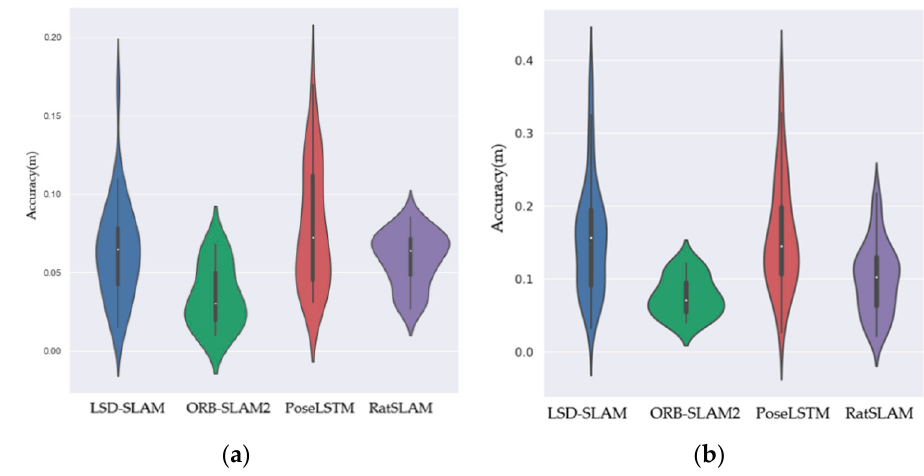
Figure 6. Accuracy comparison of vision-only methods. ( a ) Sequence 1. ( b ) Sequence 7.